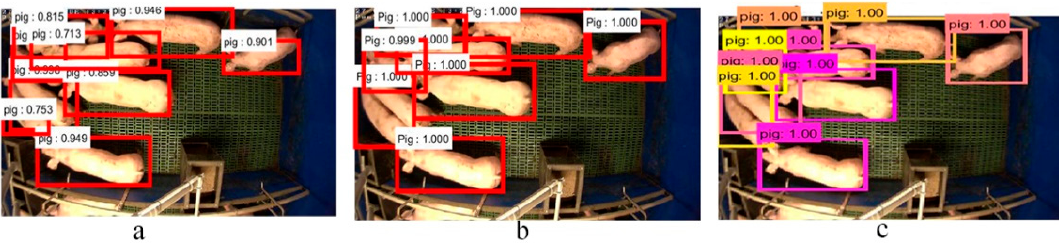
Figure 5. Comparisons of different detection architectures. The detection results shown in ( a – c ) are produced from the R ‐ FCN, Faster ‐ RCNN and SSD,